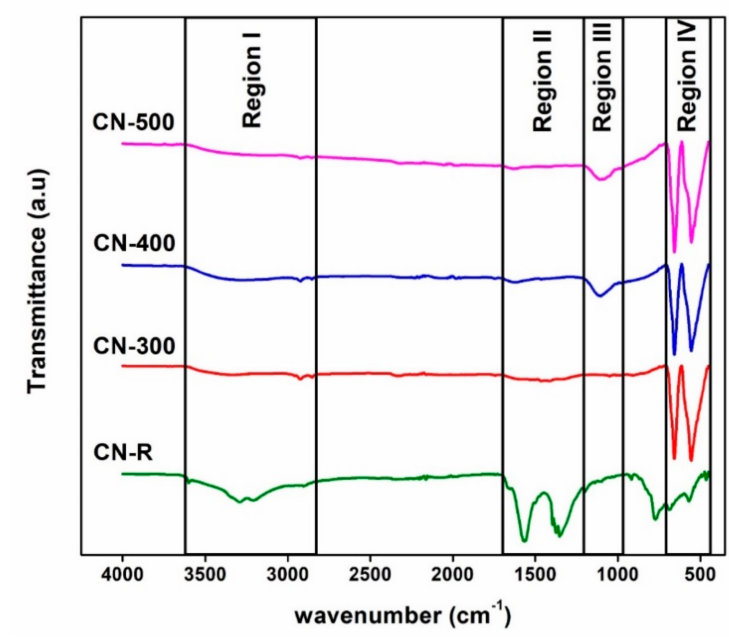
Figure 6. FTIR transmittance spectrum of all